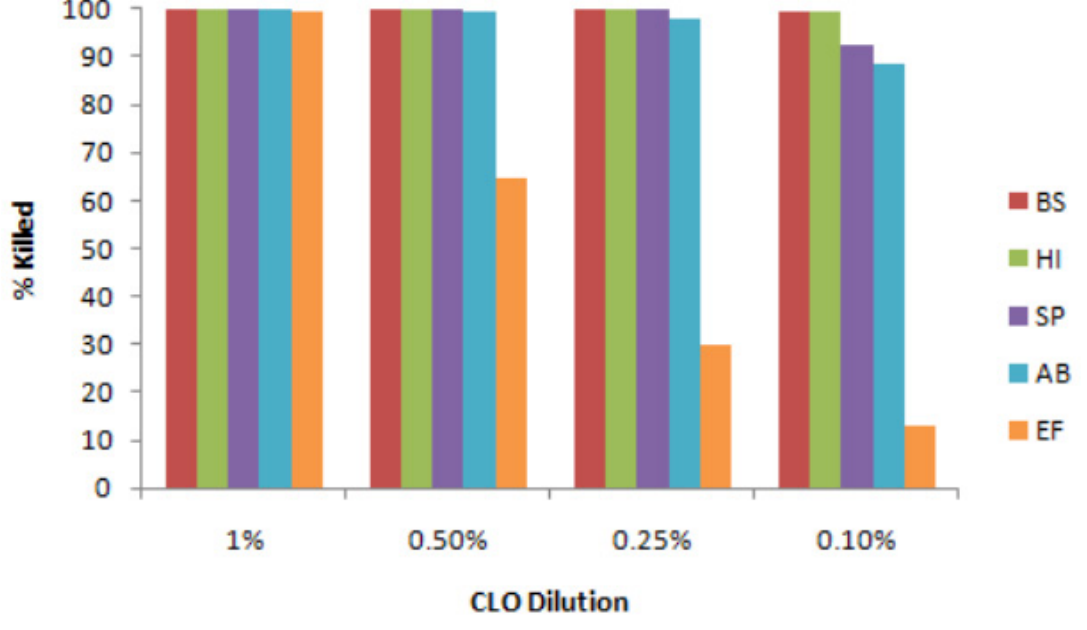
Figure 2. Effect of CLO against different bacteria. Reactions, containing 1,500 cfu of each bacterium in 100 µL of saline and the indicated concentration of CLO, were incubated at 22 °C for 60 min. Bacteria were then pelleted by centrifugation, washed and assayed for cfu, in comparison with unexposed control bacteria. BS = B. subtilis , HI = H. influenzae , SP = S. pyogenes , AB = A. baumannii , EF = E. fecalis